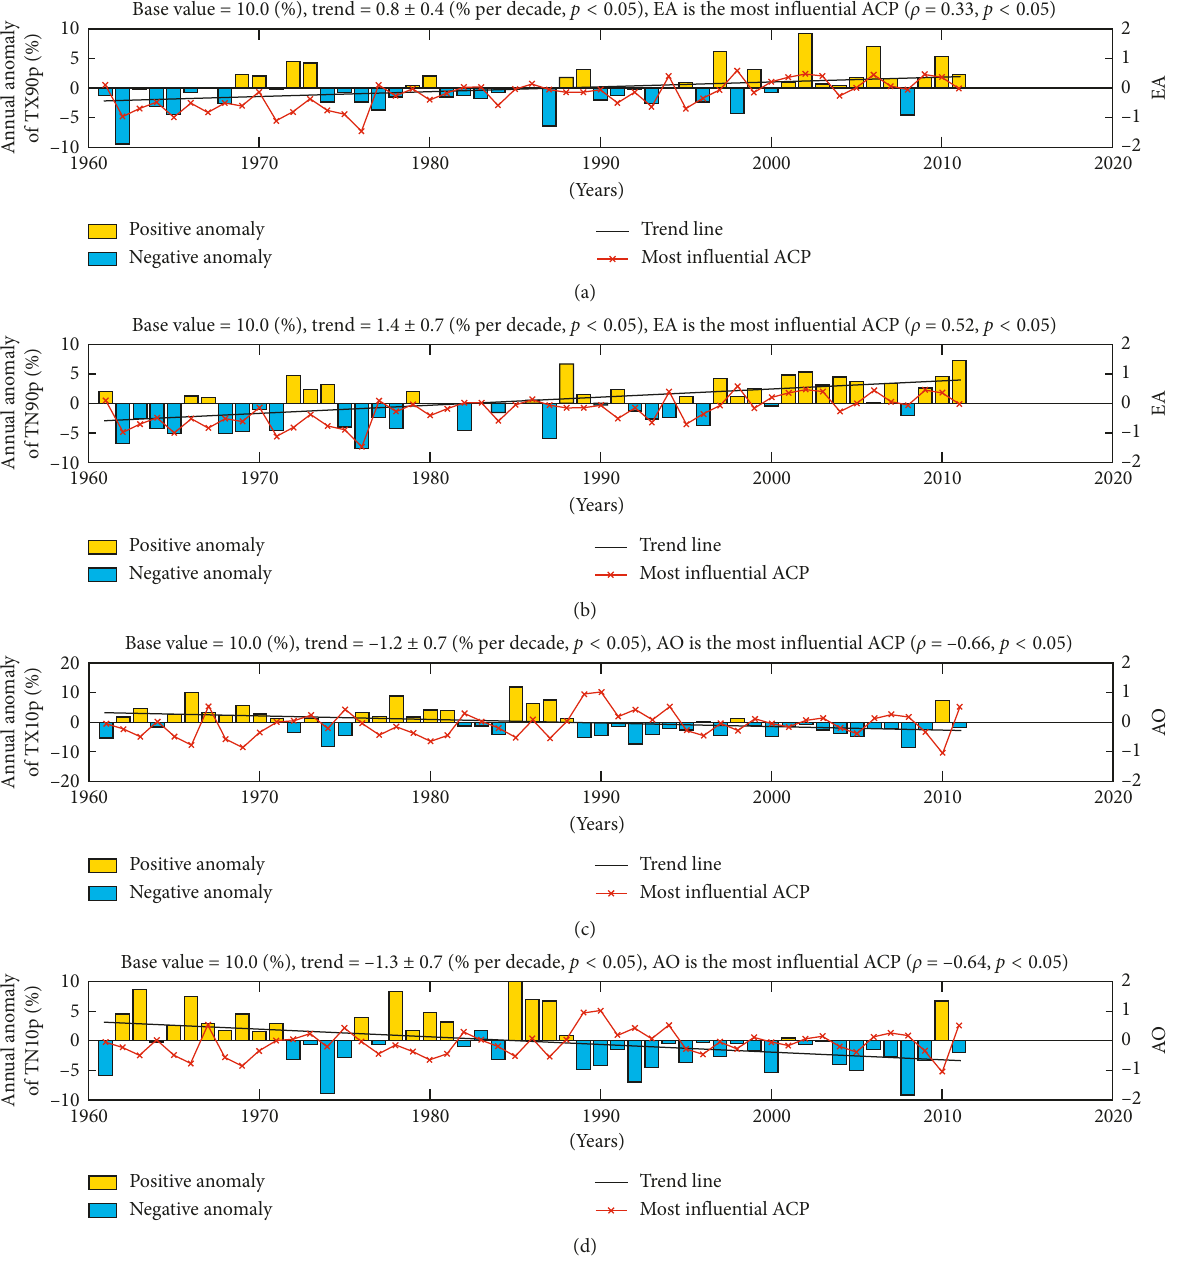
Figure 2: Time series with trend line and most influential NHTP for (a) TX90p, (b) TN90p, (c) TX10p, and (d) TN10p, on the country scale in Finland during